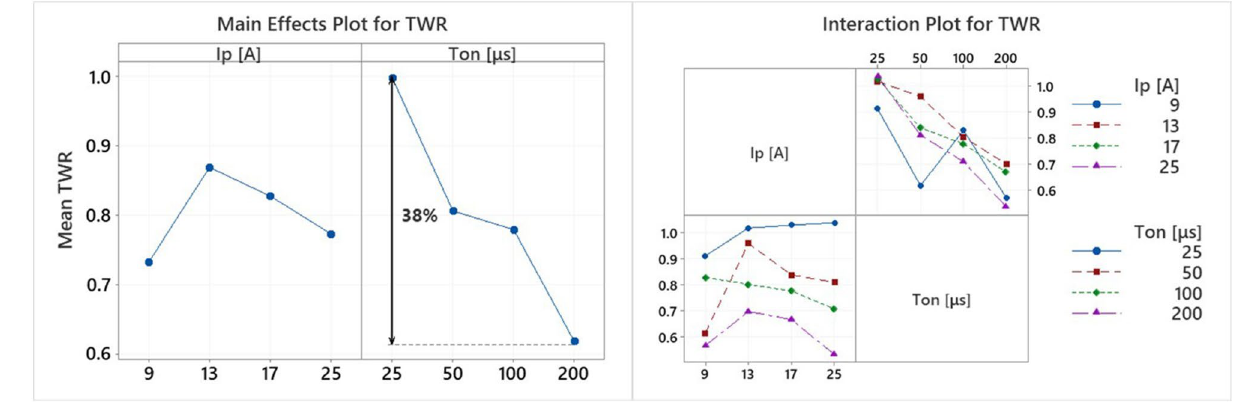
Figure 7. Main Effects Plot and Interaction Plot of TWR.